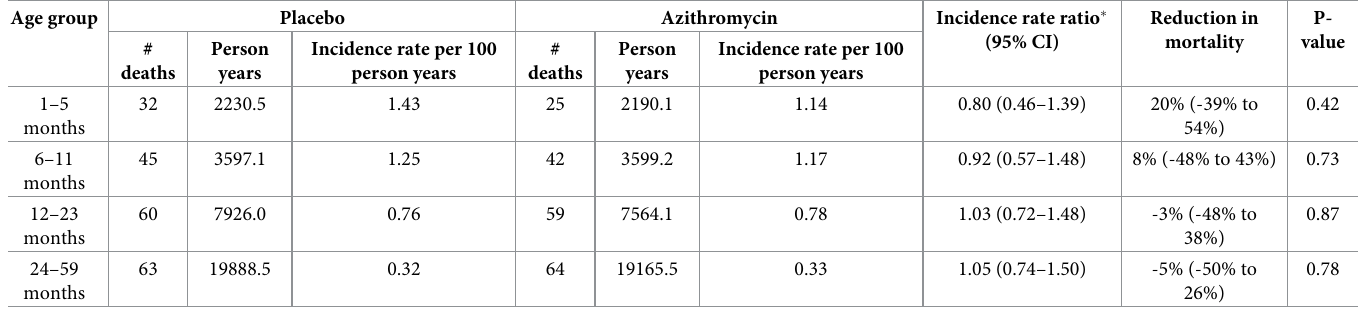
Table 1. Mortality all causes by age group and